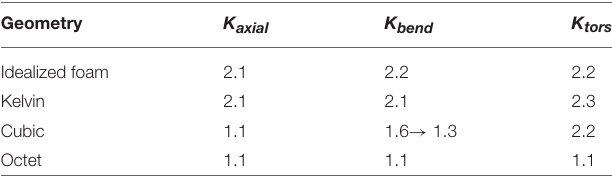
TABLE 3 | Scaling exponents for power-law approximations of axial, bending, and torsional stiffness of finite